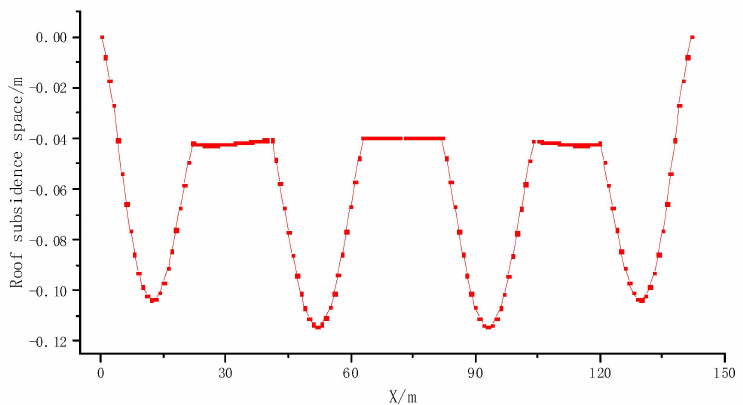
Figure 9. Spatial distribution of roof subsidence of